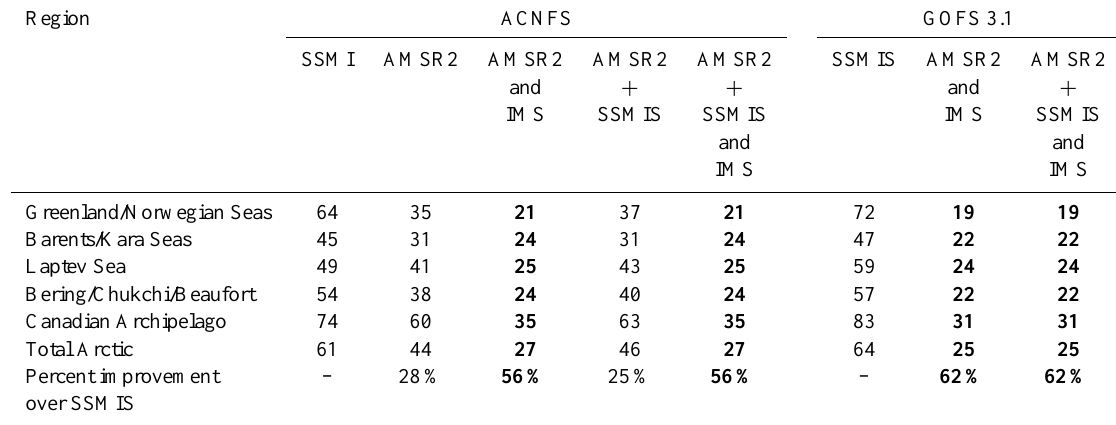
Table 3. Regional mean distance differences (km) between the NIC ice edge and 6h ACNFS or 12h GOFS 3.1 forecasts initialized from various combinations of SSMIS, AMSR2 and IMS data for the time period June–August 2014. The bottom row shows the total Arctic percent improvement from each ice forecasting system compared to using SSMIS assimilation alone. The bold numbers denote the smallest mean distance error between the assimilation test